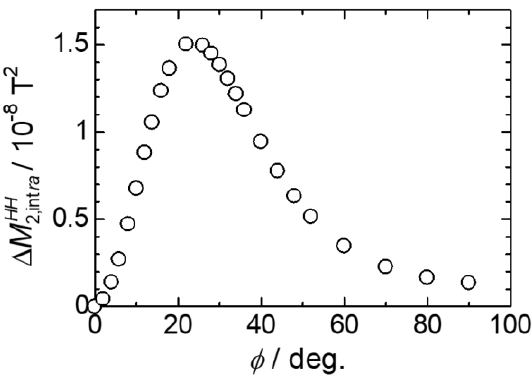
Figure A1. Reduction in the 1 H second moment due to intramolecular 1 H- 1 H dipolar interactions in the 4,4'-bipyridine moiety.